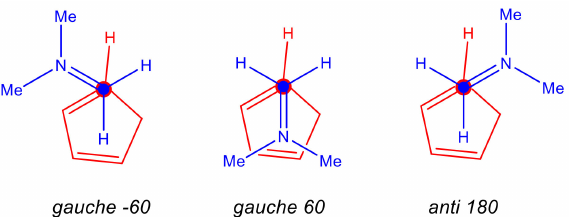
Figure 11. Three feasible stereoisomeric reaction paths associated with the C4 and C5 two-center interaction in the I-DA reaction of Cp 1 with iminium cation 6 .